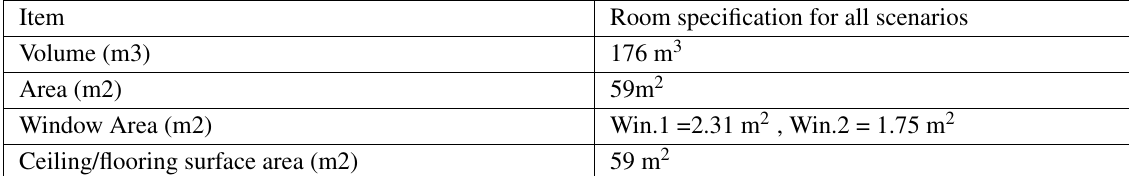
Table 1. The geometric configuration of the master